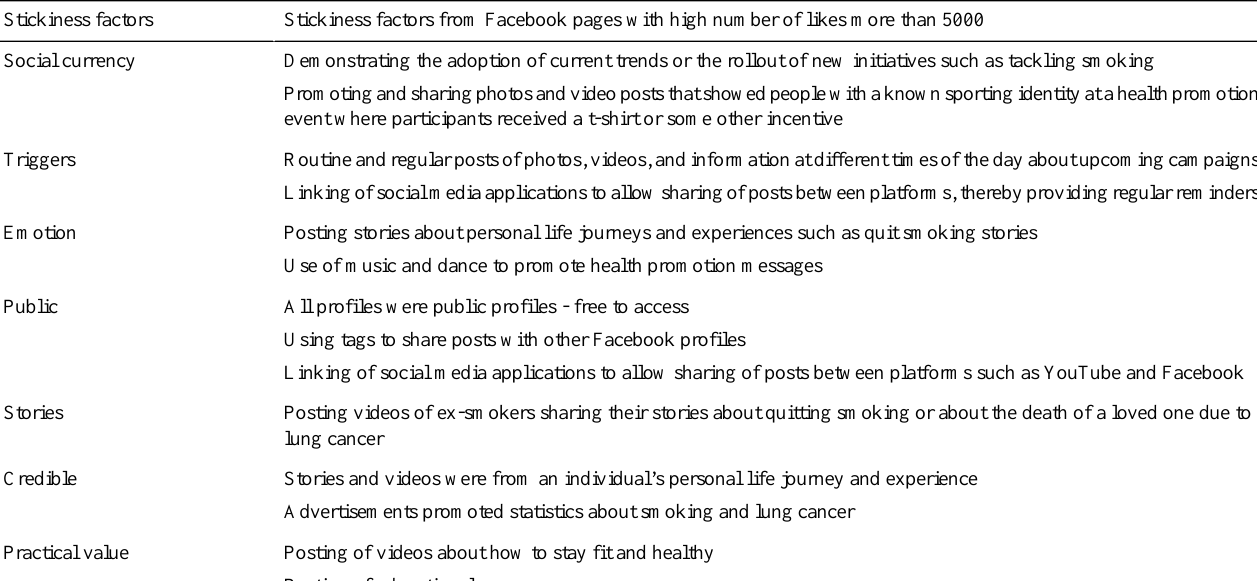
Table 5. Stickiness factors associated with Facebook pages with likes more than 1000. Stickiness factors from Facebook pages with high number of likes more than 5000Stickiness factors Demonstrating the adoption of current trends or the rollout of new initiatives such as tackling smoking Promoting and sharing photos and video posts that showed people with a known sporting identity at a health promotion event where participants received a t-shirt or some